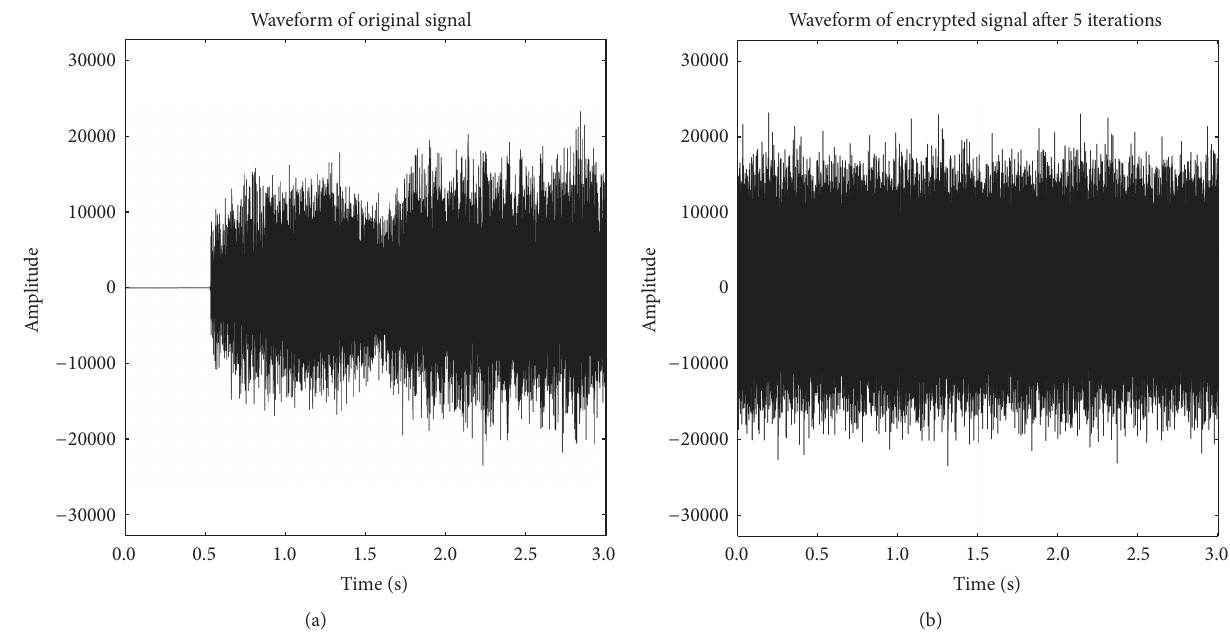
Figure 2: Comparison of the first three seconds of signal waveforms. (a) Original signal; (b) encrypted